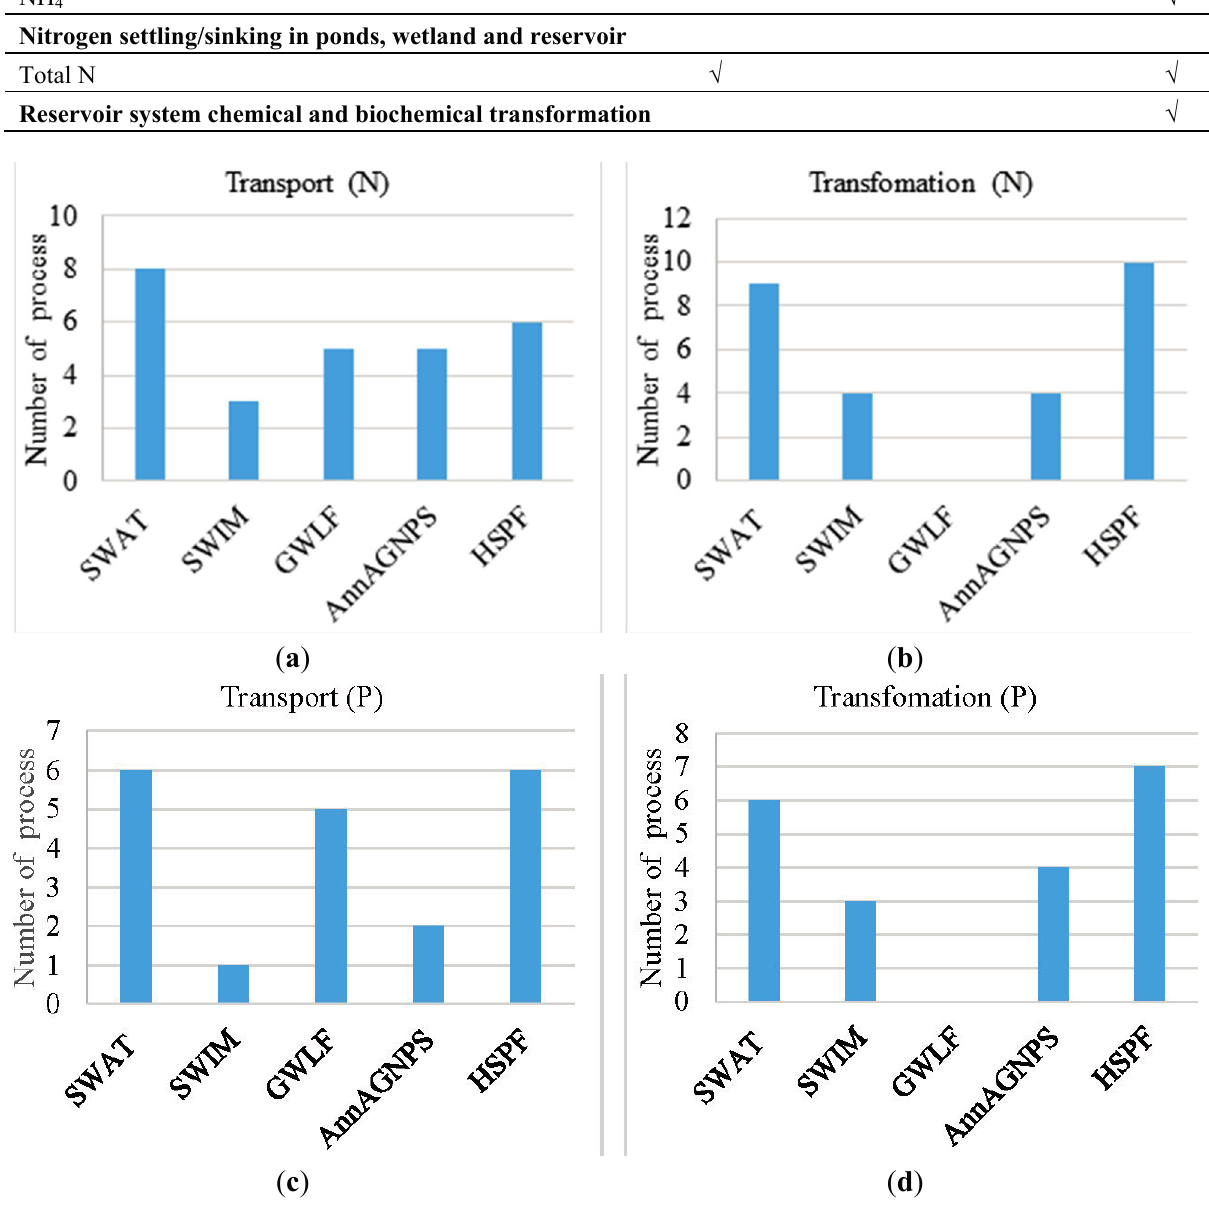
Figure 4. Numbers of transport and transformation processes involved in the nutrient outputs: ( a ) N transport processes; ( b ) N transformation processes; ( c ) P transport processes; ( d ) P transformation